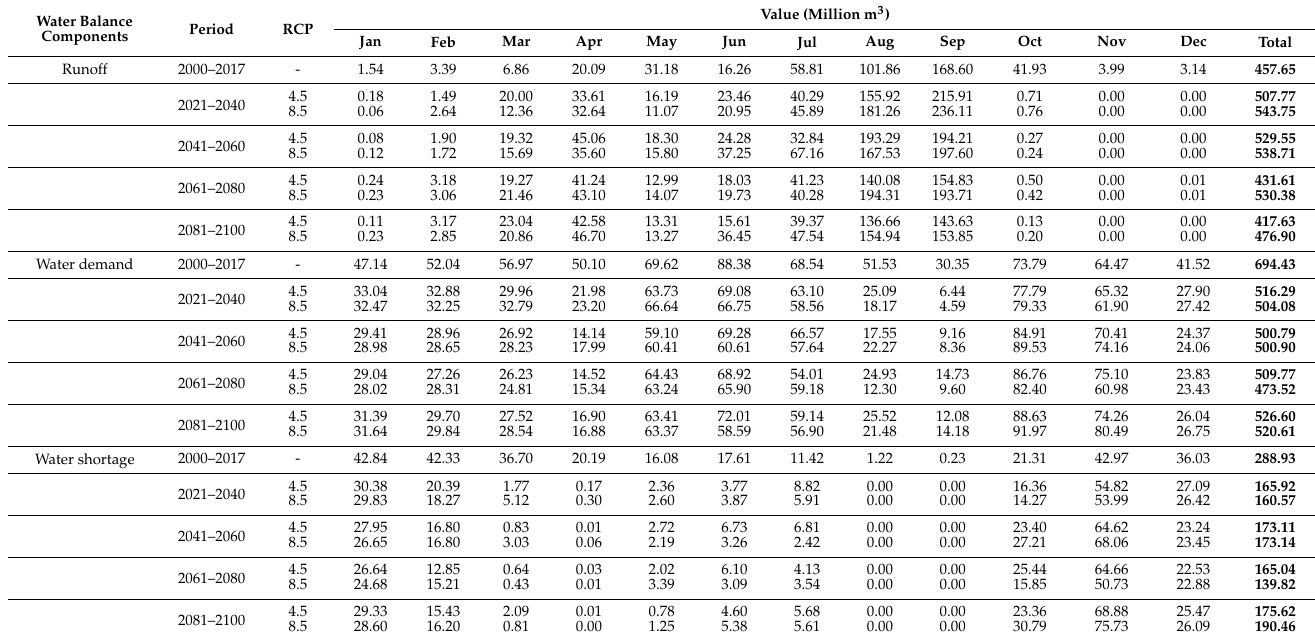
Table 4. Simulated mean monthly water balance results for the baseline and climate scenarios for the Lam Phaniang River Basin. WaterBalance Components